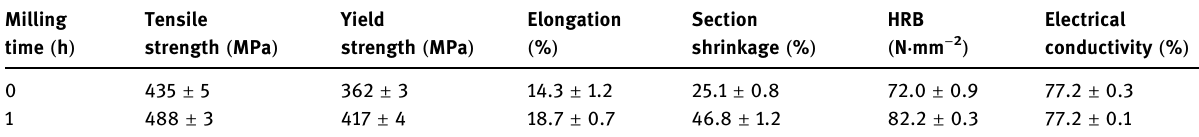
Table 2: Mechanical and physical properties of dispersion - strengthened copper alloy before and after ball milling Milling time ( h )